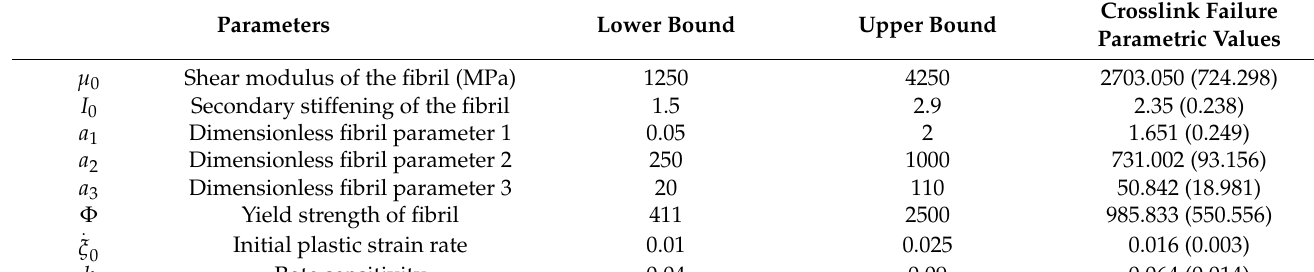
Table 4. Material parameters of the fibril found via the data-fitting procedure.